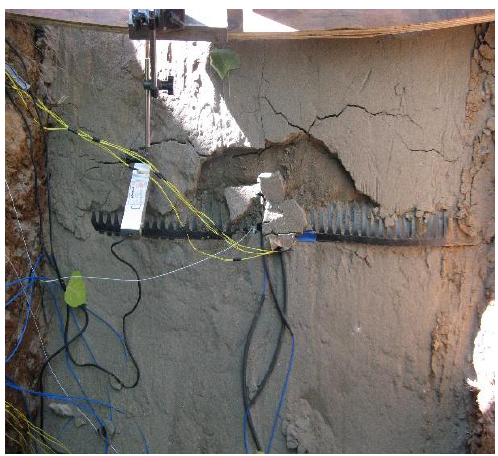
Figure 5. Crack development and damage of slope in the test.